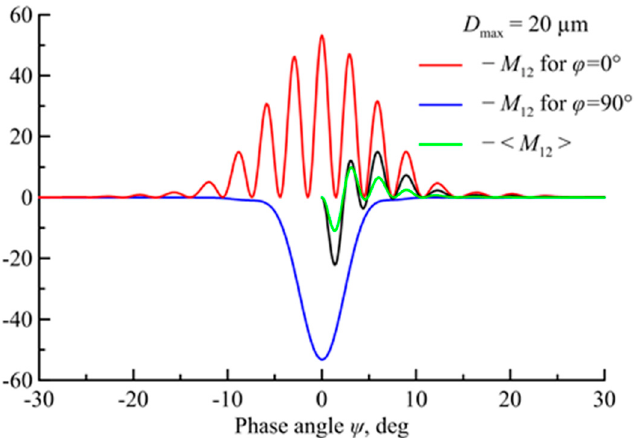
θϕ ( , ) M of Figure 10b plotted for: (a) two perpendicular meridians =ϕ 0 Figure 11. Element Figure 11. Element M 12 ( θ , ϕ ) of Figure 10b plotted for: (a) two perpendicular meridians ϕ = 0 (red) 12 and ϕ = π /2 (blue); (b) their average (black), and (c) averaged over ϕ (red) and =ϕ π / 2 (blue); (b) their average (black), and (c) averaged over ϕ (green).